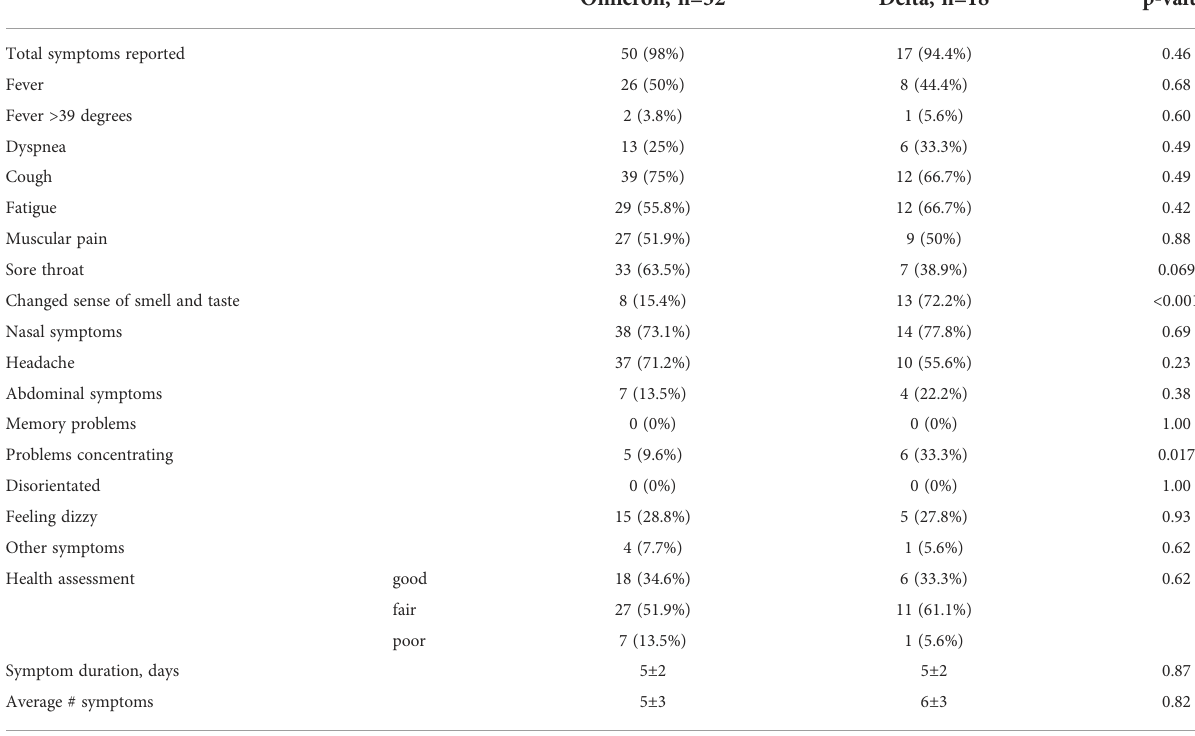
TABLE 2 Symptoms.